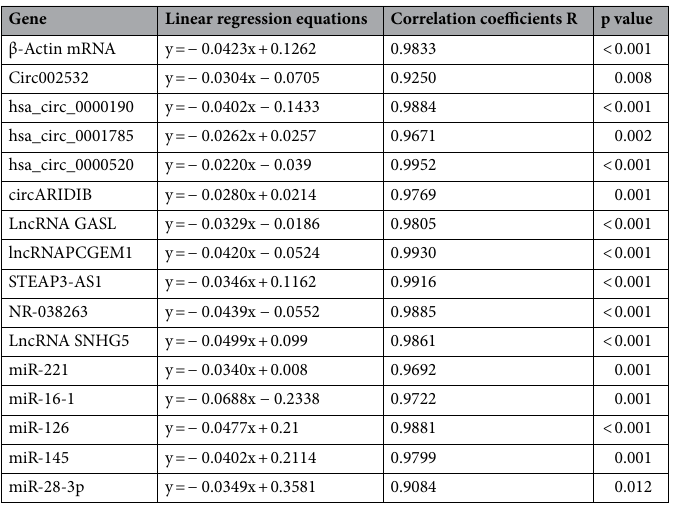
Gene Linear regression equations Correlation coefficients R p